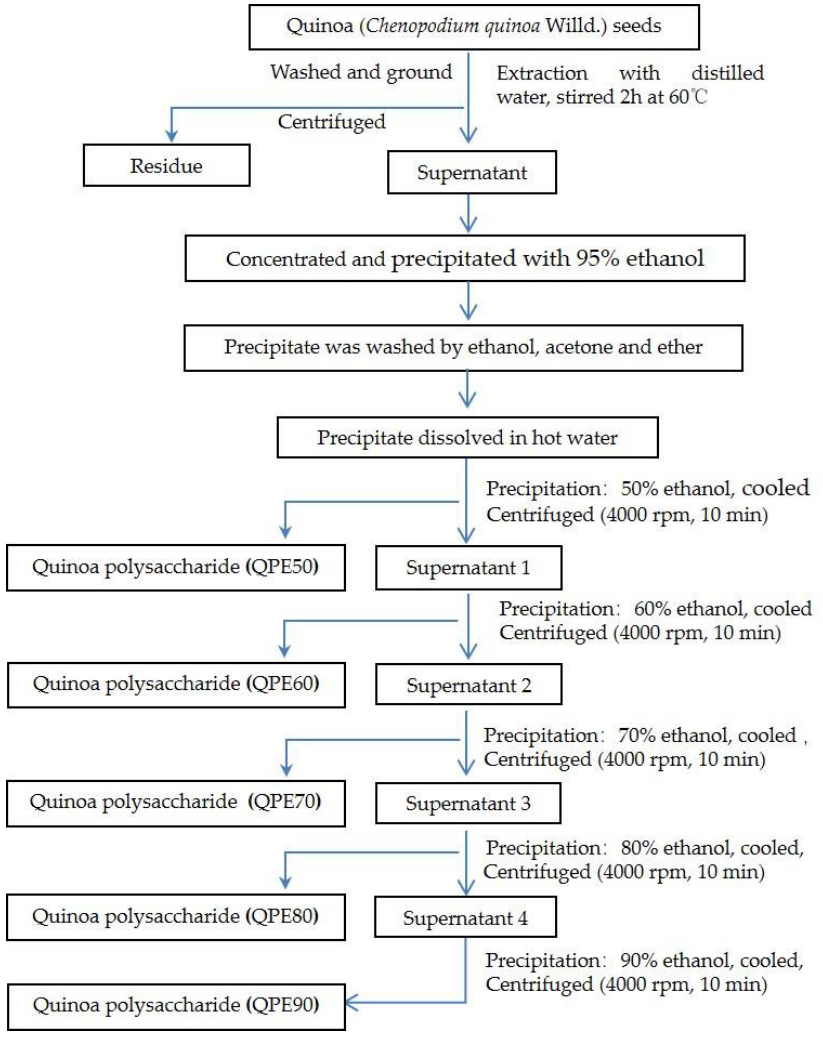
Figure 8. Flow chart of extraction and isolation of polysaccharides from quinoa.